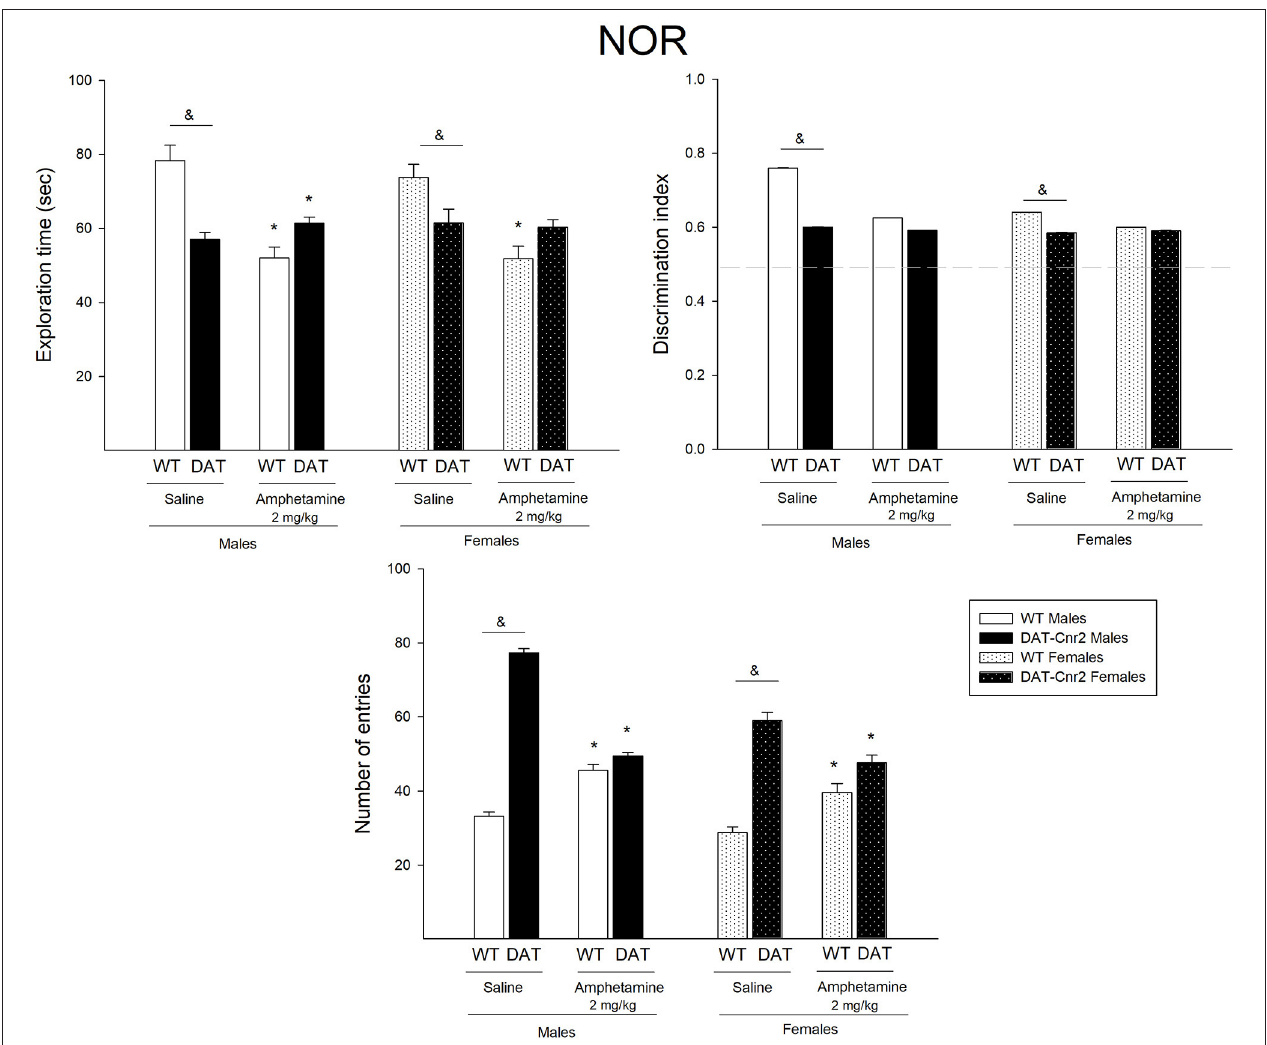
FIGURE 7 | Performance of adolescent DAT- Cnr2 male and female mice in response to a single administration of a low dose of amphetamine on the NOR test. The exploration time of DAT- Cnr2 and WT mice. Discrimination index of both genotypes and on the total number of entries of both genotypes. Data are depicted as mean ± SEM. The white bars represent the WT and the black bars represent DAT- Cnr2 cKO mice. Males depicted in clean bars and females in bars with dots. Data are expressed as mean ± SEM ( n = 10 mice per group). Three-way ANOVA followed by Tukey post hoc test * p < 0.05 for treatment and & p < 0.05 for